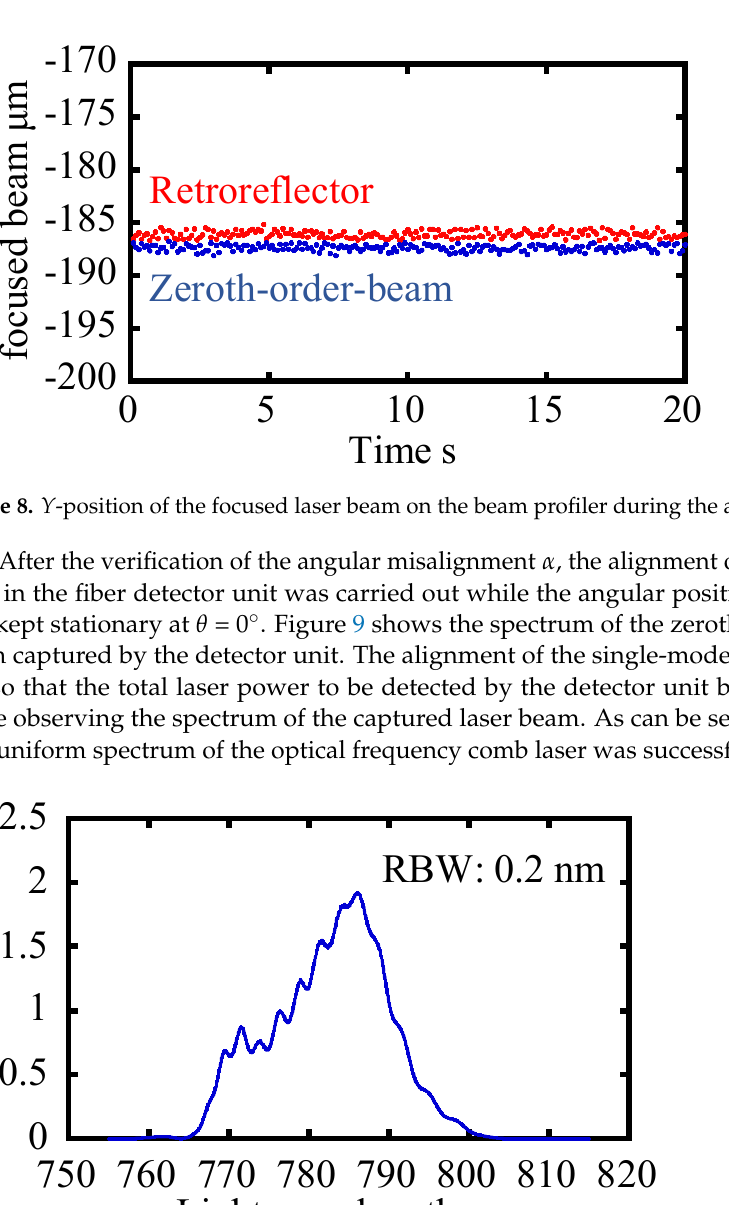
Figure 7. Alignment of the measurement laser beam by using a retroreflector and a beam profiler: ( a ) Setup with a retrore- flector; ( b , c ) Procedure of the alignment.